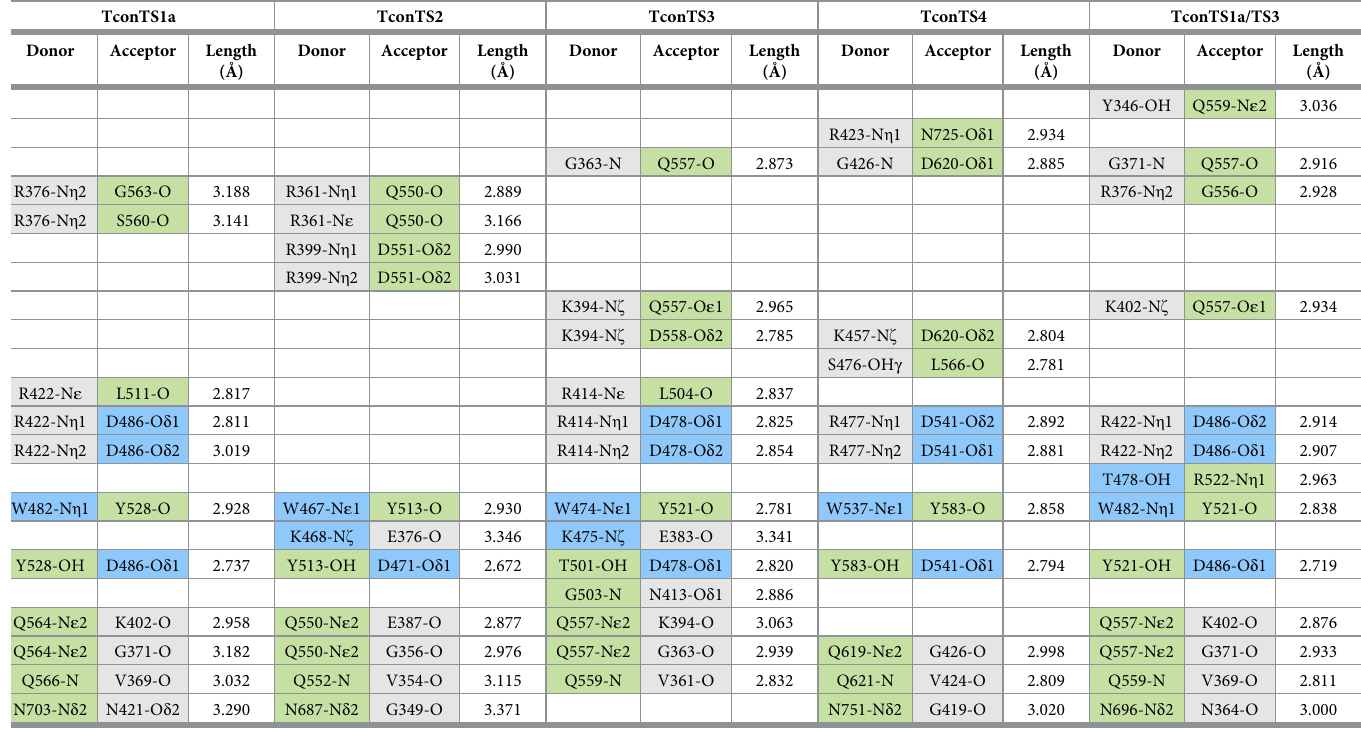
Table 2. Hydrogen bonds formed by amino acid residues at the contact site between CD and LD of TconTS and domain swapped TconTS1a/TS3 as a model system. TconTS1a